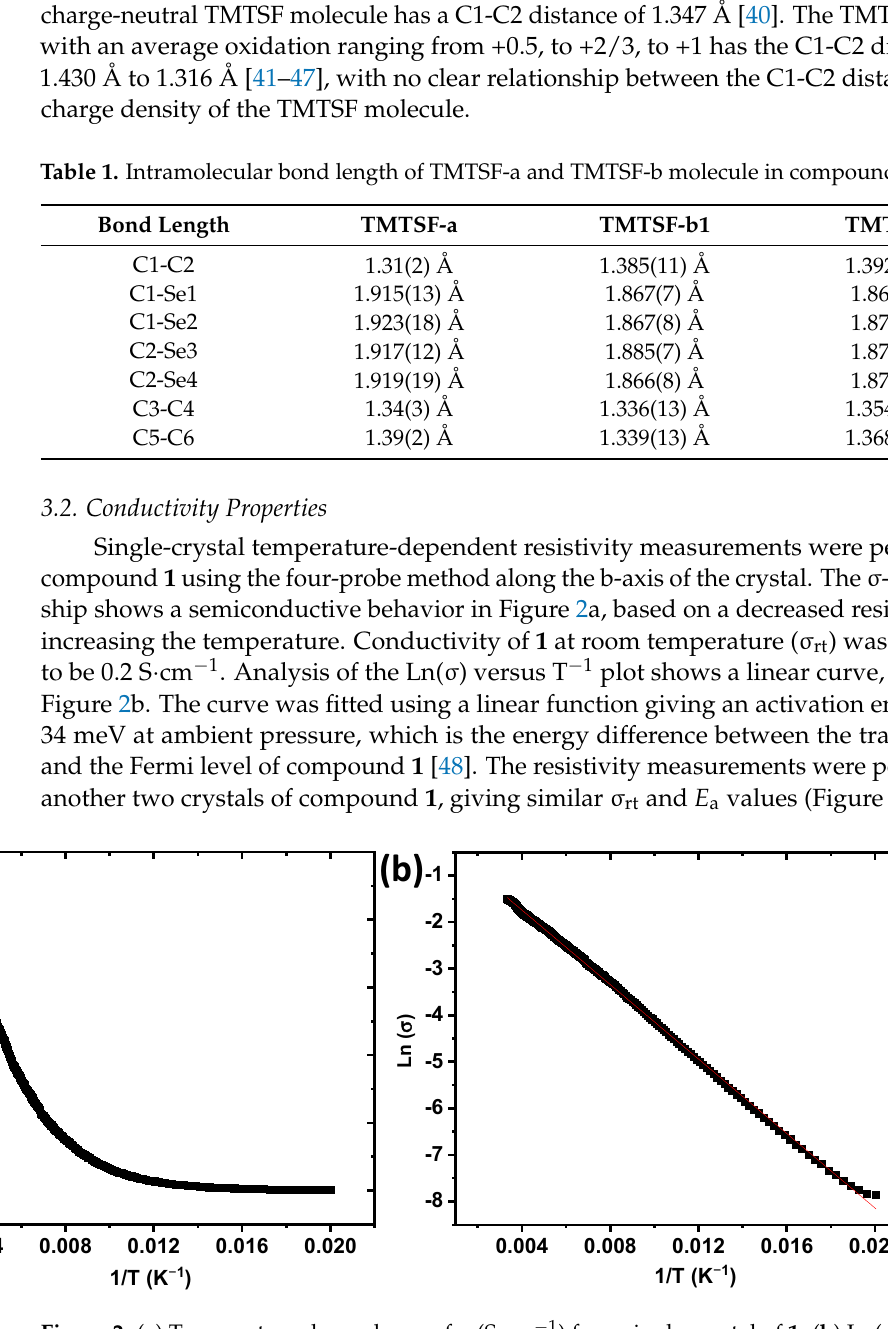
Figure 2. ( a ) Temperature dependence of σ (S · cm − 1 ) for a single crystal of 1 . ( b ) Ln( σ )-T − 1 and its fitting curve to a linear function (red line).